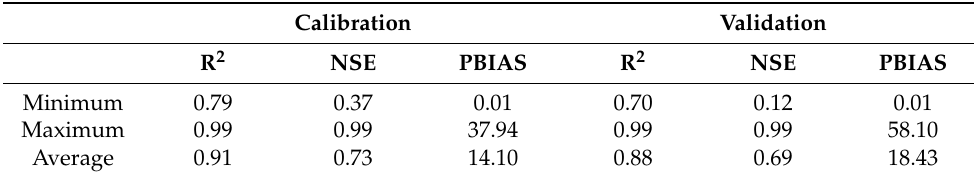
Table 4. Minimum, maximum, and average values of the coefficient of determination (R 2 ), Nash- Sutcliffe coefficient of efficiency (NSE), and percent bias (PBIAS) in daily streamflow calibration and validation for 30 unit watersheds.